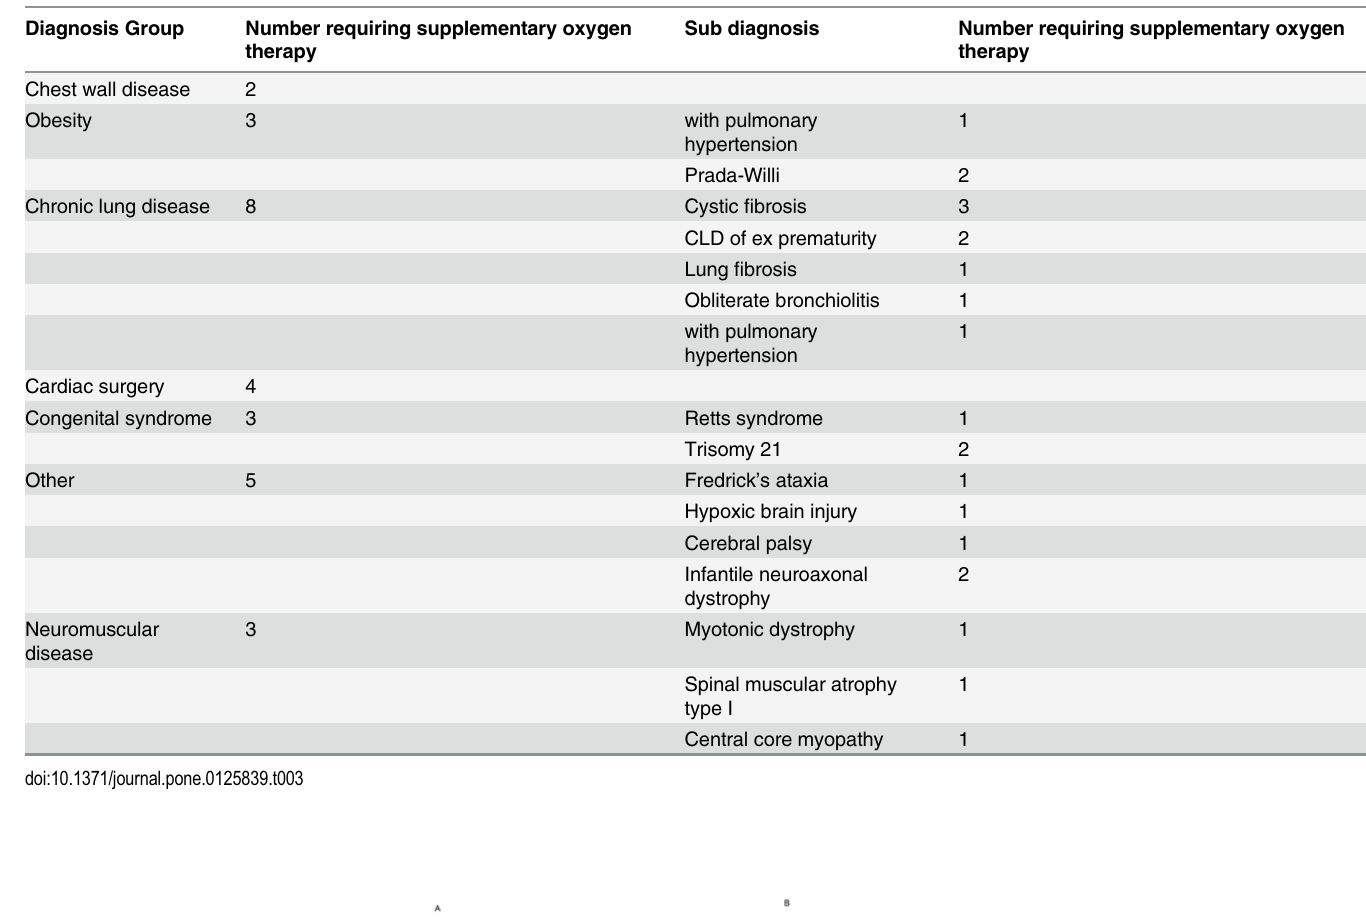
abnormalities post cardiac surgery (cardiac); central apnoea; chronic lung disease; chest wall disease; obesity hypoventilation syndrome; other diseases not classified in any other group; syndrome and upper